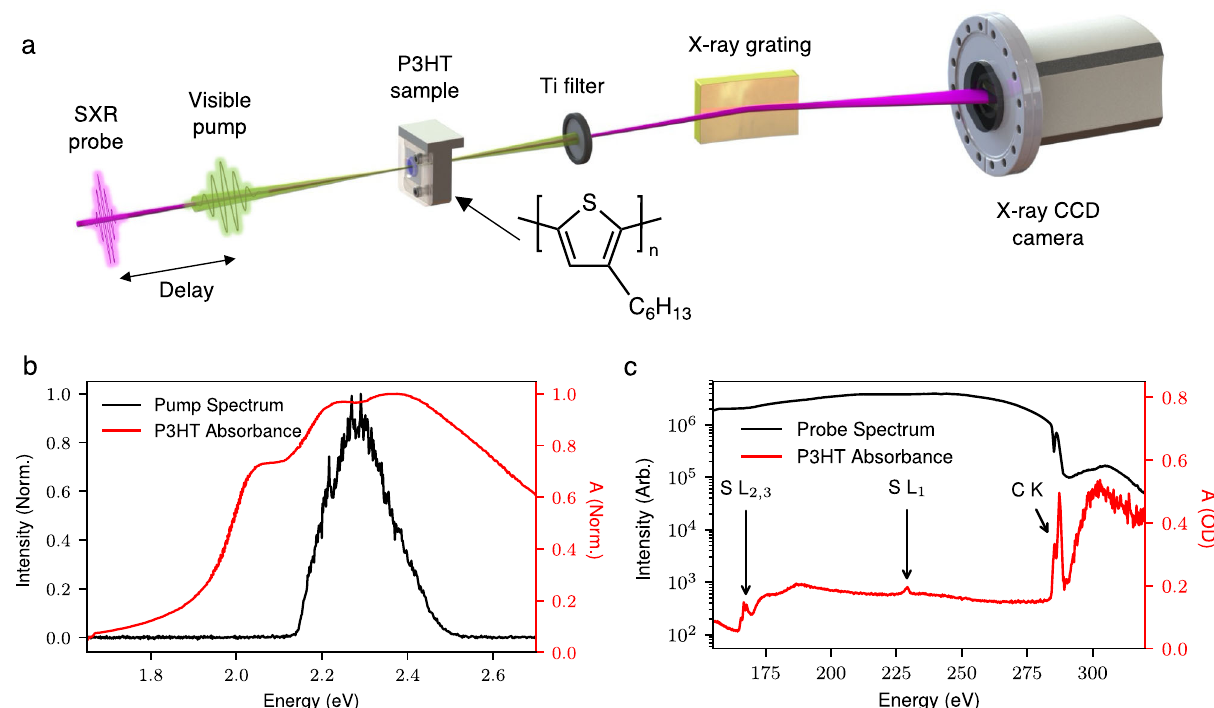
Fig. 1 Experimental methodology and static absorption spectra of P3HT. a The experimental setup for time-resolved soft X-ray spectroscopy. A 15 fs visible pump pulse excites the π → π * transition in P3HT, and a temporally delayed attosecond soft X-ray pulse probes the carbon and sulfur absorption edges. b The visible absorption spectrum of the P3HT samples used in this work, and the pump pulse spectrum which is centered at the maximum of the π → π * resonance in P3HT. c A typical soft X-ray spectrum extending to ~330 eV (black line). The red line is the X-ray absorption spectrum of the P3HT sample, absorption features at the sulfur L 1,2,3 and carbon K-edges are resolved simultaneously. The assignment of the absorption peaks are discussed in the main text.